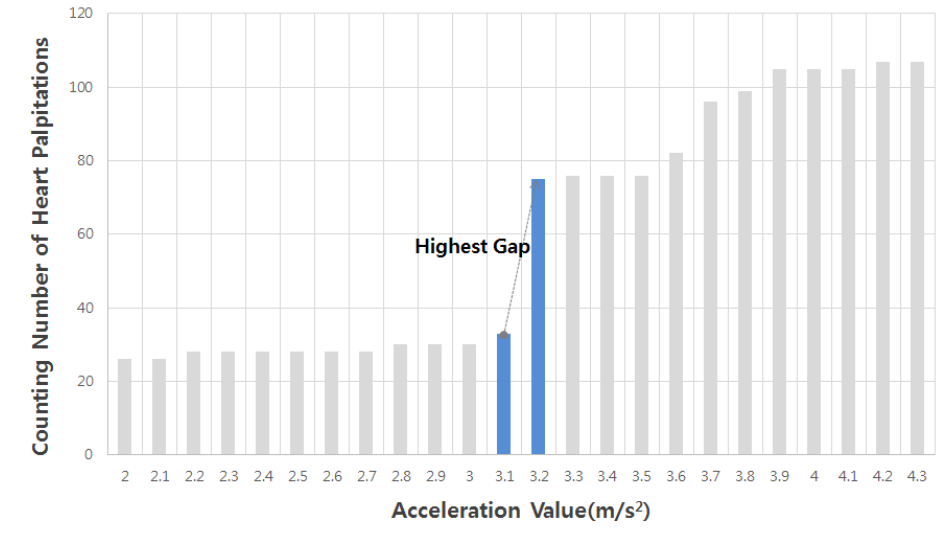
Figure 7. Histogram of the heart palpitation summation at every acceleration value per 0.1 m/s 2 . As shown here, the safe driving intensity value is 3.1 according to the highest gap obtained using this method.